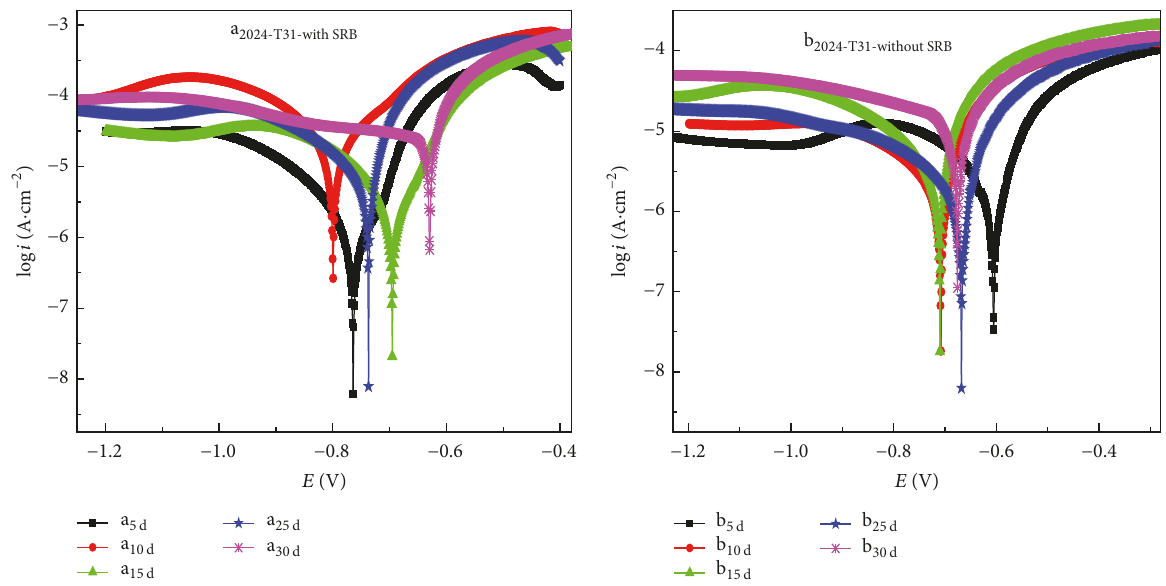
Figure 3: The polarization curves of 2024-T31 aluminum-magnesium alloy immersed in a and b experimental system for 5–30 d.